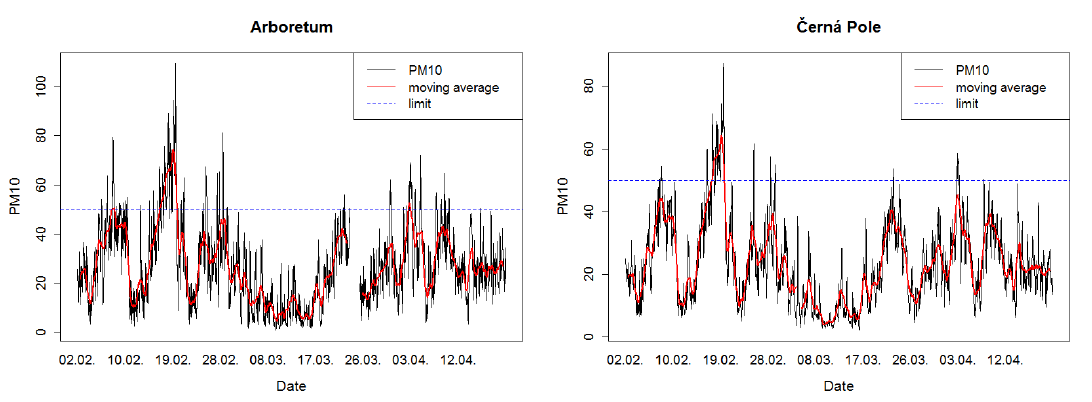
Figure 4. PM 10 with a 24 h moving average ( µ g · m − 3 ) and limit value of 50 µ g · m − 3